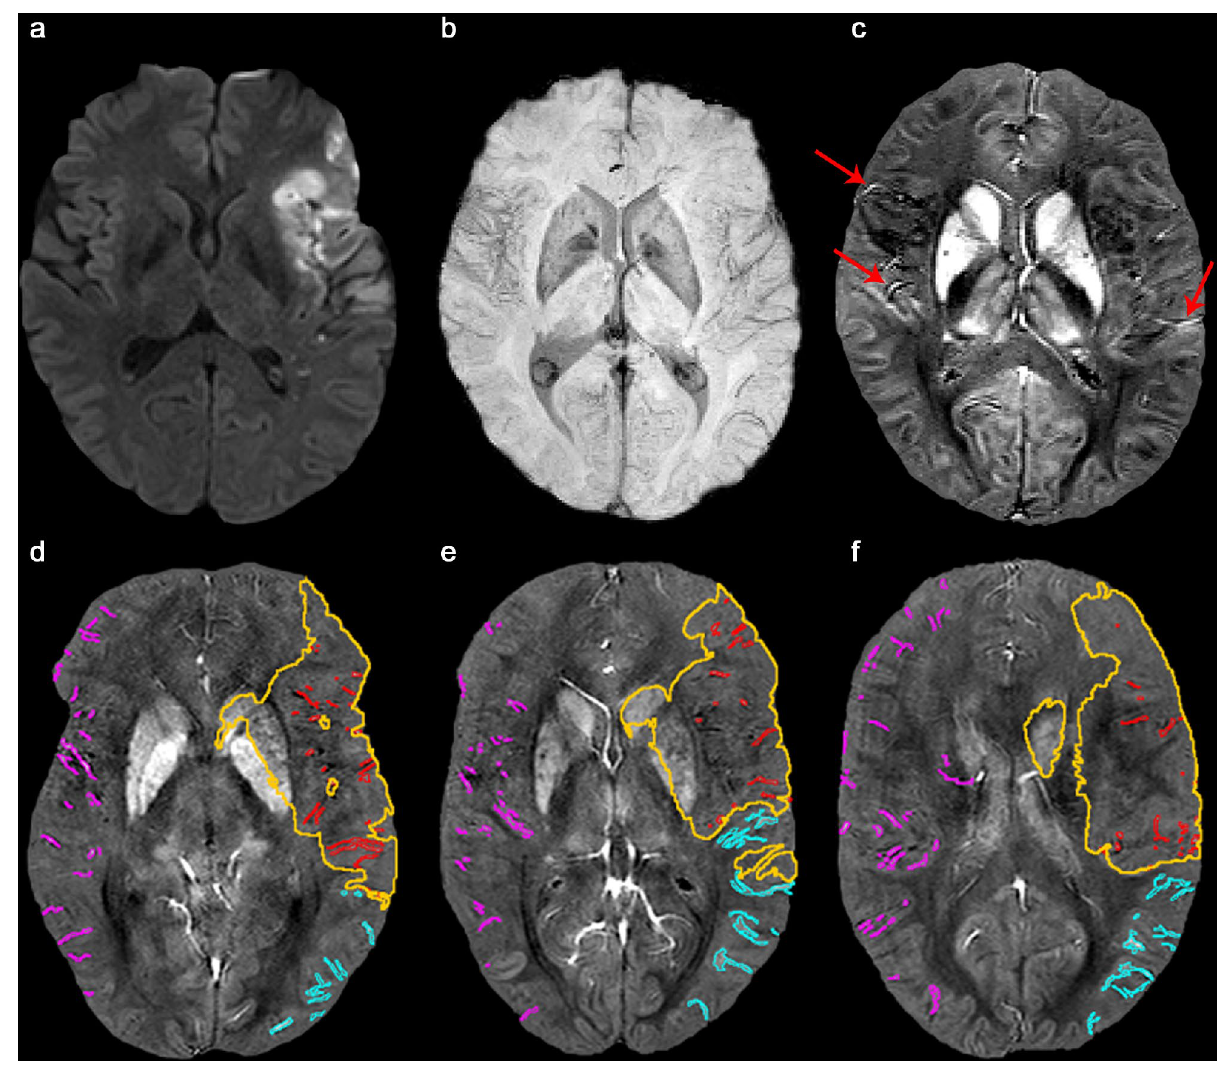
Figure 2. MR images of a stroke patient aged 49 years with successfully recanalized MCA-M1 occlusion on the left hemisphere. The DWI ( a ) shows the hyperintense infarct area on the left hemisphere. The SWI ( b ) helps identifying the localization of vessels. The corresponding susceptibility map is depicted in ( c ). Veins with higher levels of paramagnetic deoxyhemoglobin content appear brighter (red arrows). Representative susceptibility images covering the MCA territory are shown in ( d – f ). Cortical veins are delineated in different colors depending on the territory. Within the stroke area (yellow line) defined by DWI cortical veins are delineated in red, those within the ipsilateral non-ischemic MCA territory in cyan and those in the contralateral MCA territory in between veins within the stroke core, the ipsilateral non-ischemic MCA territory and the contralateral MCA territory. The stroke core was identified as hyperintense tissue signal on DWI and delineated semiautomatically utilizing the ImageJ threshold tool for delineation and manual correction with a consistent threshold for each individual. Thresholds for stroke core delineation were divergent between individuals. Statistical analyses. All statistical analyses were perfomed using the IBM SPSS Statistics software ver- sion 25. Comparisons between groups were done using the non-parametric Kruskal–Wallis-test. For correlation analyses between susceptibility values, clinical parameters (NIHSS on admission and mRS after 3–5 months), severity of ADC decrease within the infarction and infarct volume, we calculated Pearson’s correlation coeffi- cient. A p-value below 0.05 was considered as statistically significant. Statement of ethics. The study was approved by the local ethics committee (Kantonale Ethikkomission Zurich; KEK-ZH-Nr 2014-0304). All procedures performed were in accordance with the ethical standards of the institutional and/or national research committee and with the 1964 Word Medical Association Declaration of Helsinki and its later amendments or comparable ethical standards. Informed consent was obtained from all participants as required by the ethics protocol.